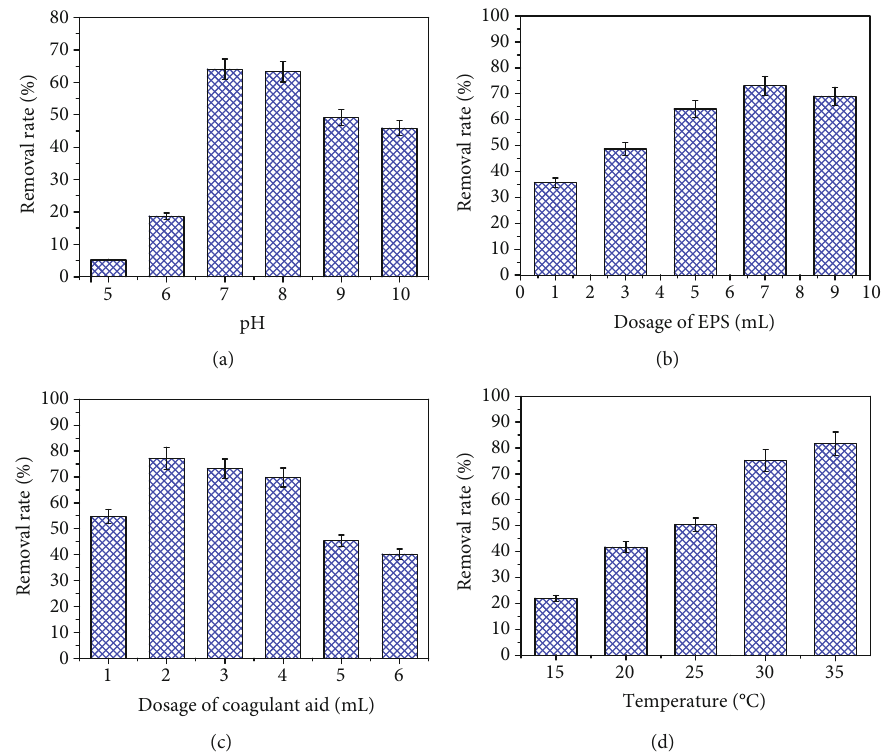
Figure 1: Removal e ffi ciency of carbamazepine on MFX at di ff erent conditions: (a) pH, (b) dosage of MFX, (c) dosage of coagulant aid, and (d) temperature.